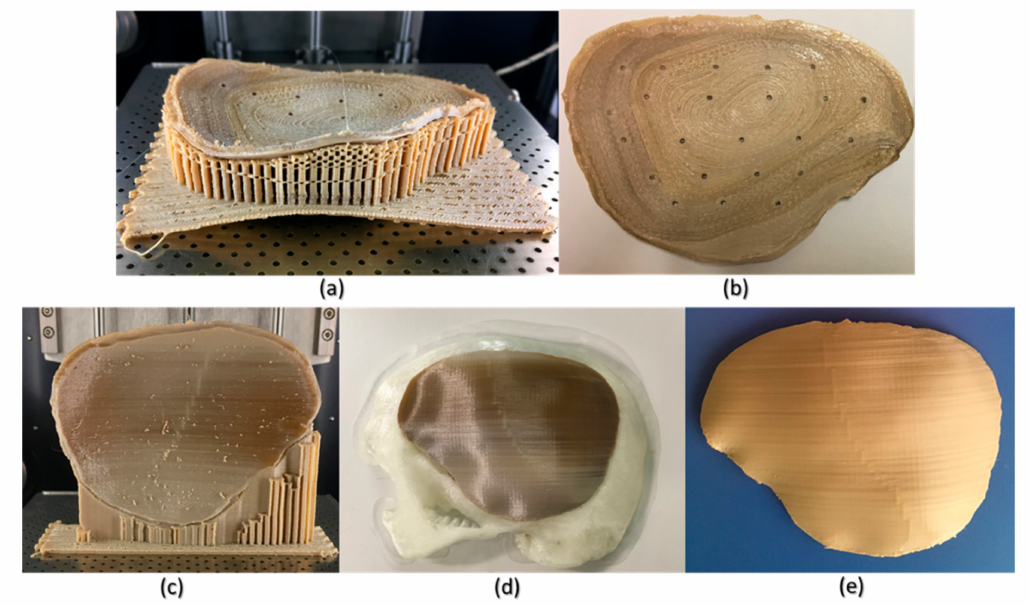
Figure 10. Illustrations of the FFF PEEK 3D printing issues in the cranial implants regarding di ff erent orientations. ( a ) horizontally printed cranial implant showing raft detachment / warping e ff ect (in situ); ( b ) horizontally printed cranial implant displaying rough internal surface; ( c ) vertical printed cranial implant exhibiting di ff erent levels of crystallinity (in situ); ( d ) 3D printed skull biomodel with